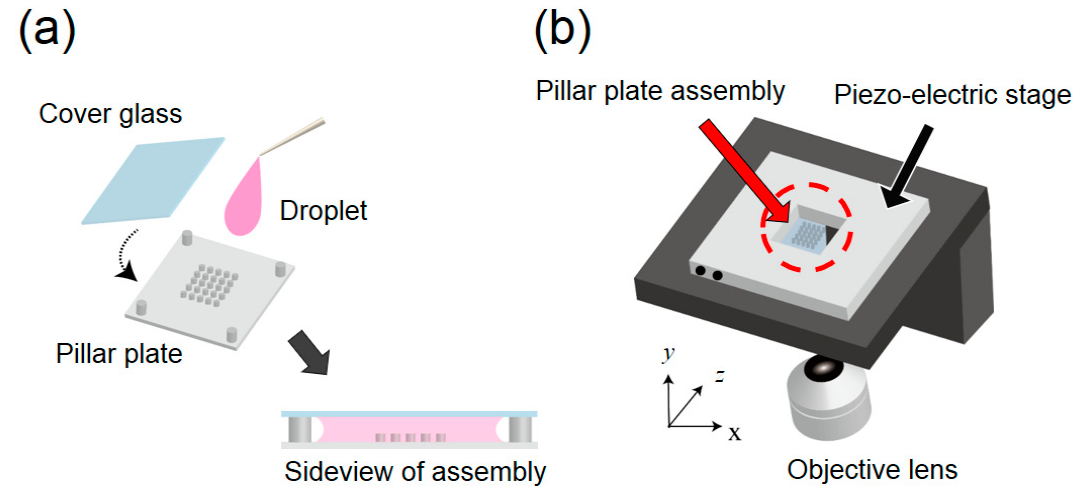
Figure 3. ( a ) Assembly of the micro-pillar plate. ( b ) Experimental setup for application of circular vibration.